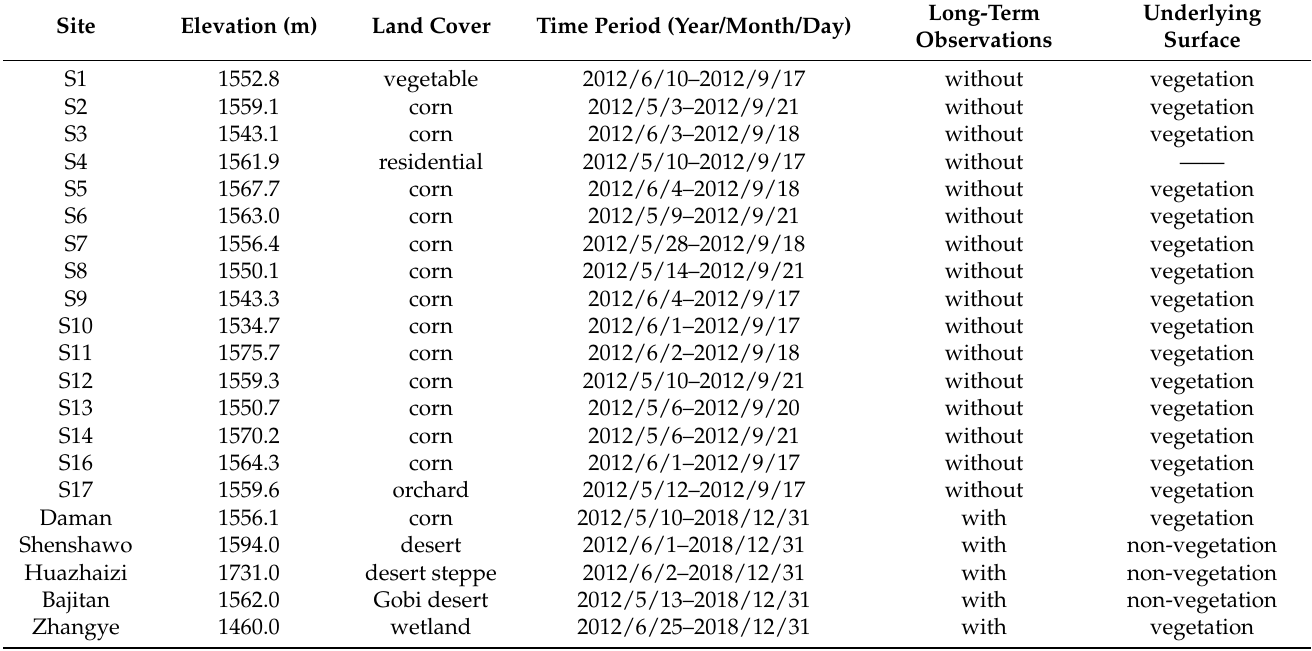
Note: Without represents the observation experiment of the site belonging to intensive observational experiments (HiWATER-MUSOEXE). With represents the observation experiment of the site belonging to intensive observational experiments and long-term observational experiments. Vegetation represents the underlying surface of the site belonging to vegetable, orchard, wetland, or corn. Non-vegetation represents the underlying surface of the site belonging to Gobi, desert steppe, or desert. —— represents the underlying surface of the site not belonging to vegetation or non-vegetation underlying